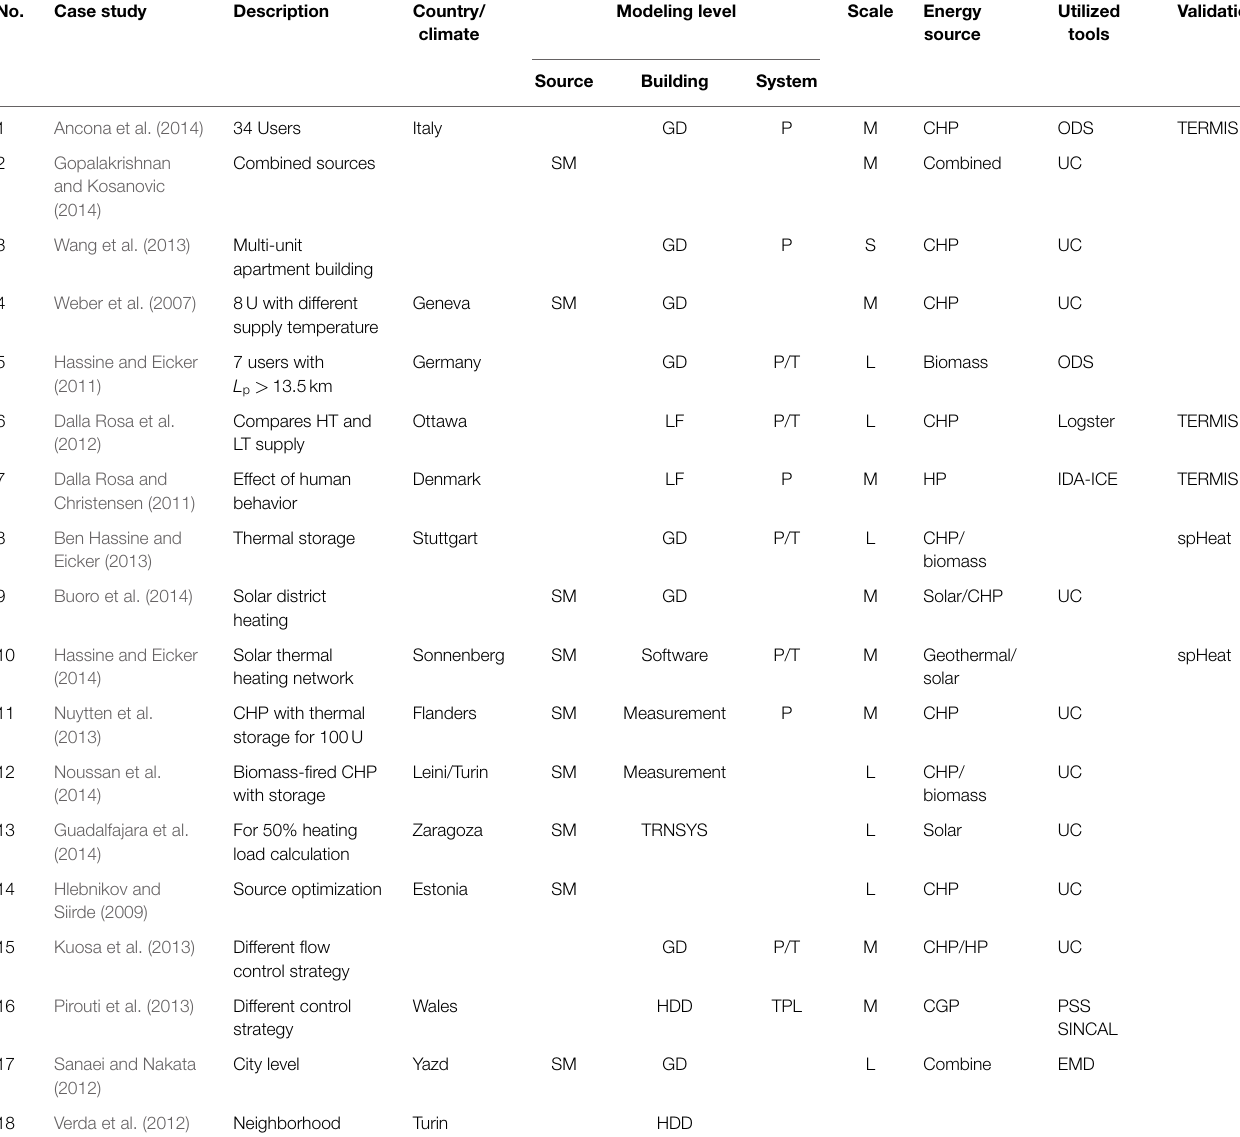
TABLE 3 | Summary of the recent DHS modeling studies